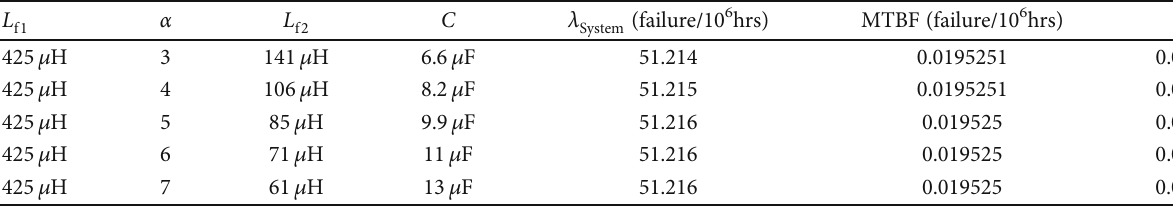
Figure 10: Comparison of the L and LCL fi lter reliability. Table 8: Filter value vs. reliability.